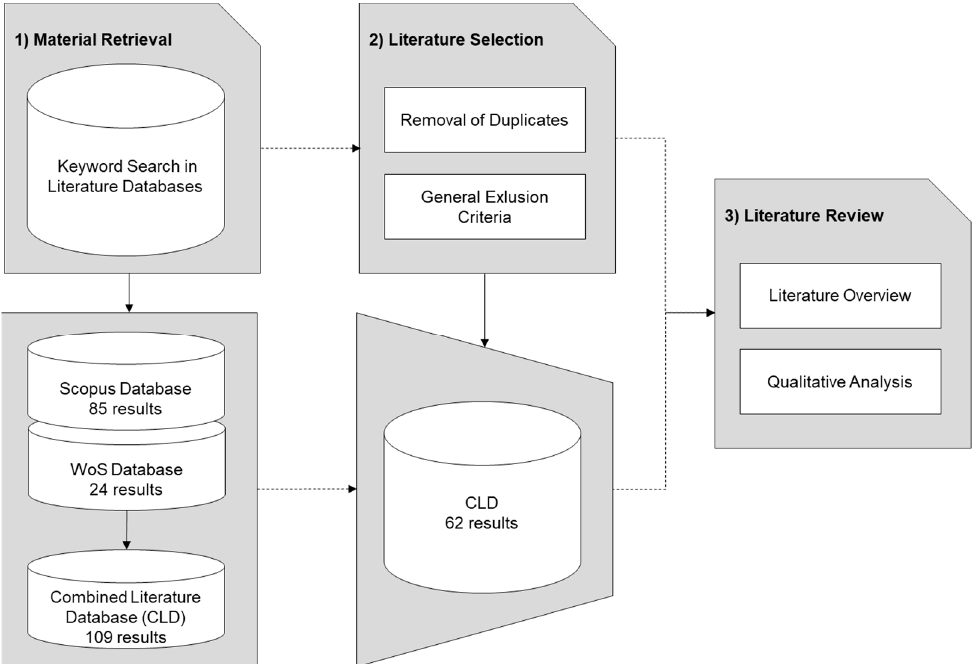
Figure 1. Systematic literature review process.